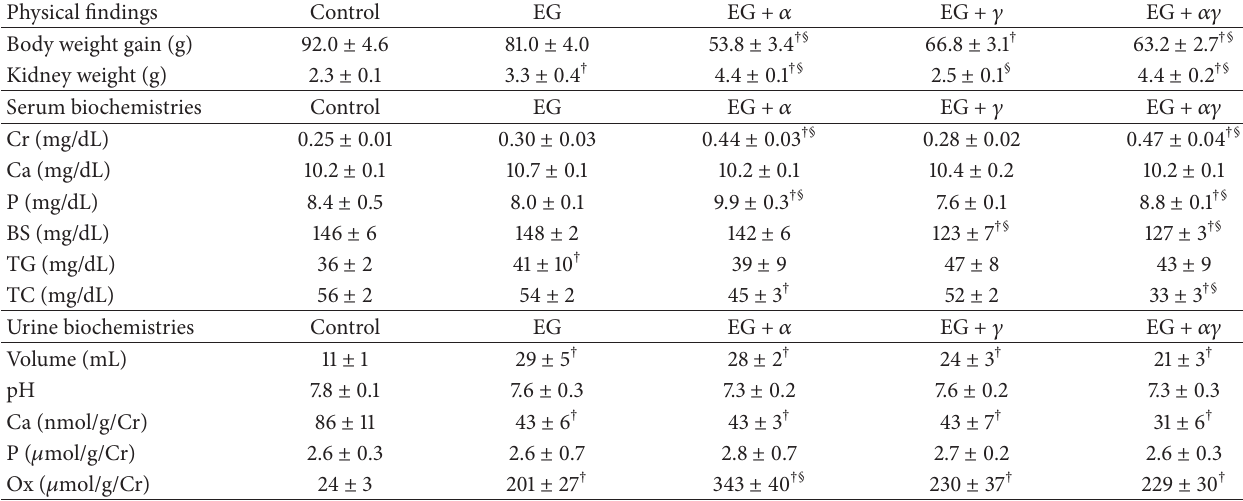
Table 1: Physical characteristics and serum and urinary biochemistry of experimental rats on day 14.